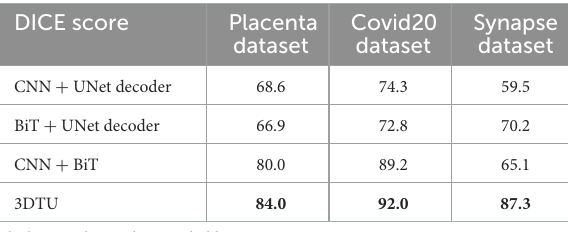
TABLE 3 Dice scores (in % ) of our 3DTU running on data that has been preprocessed with/without positional encoding. Placenta Covid20 dataset dataset 3DTU w/o Positional